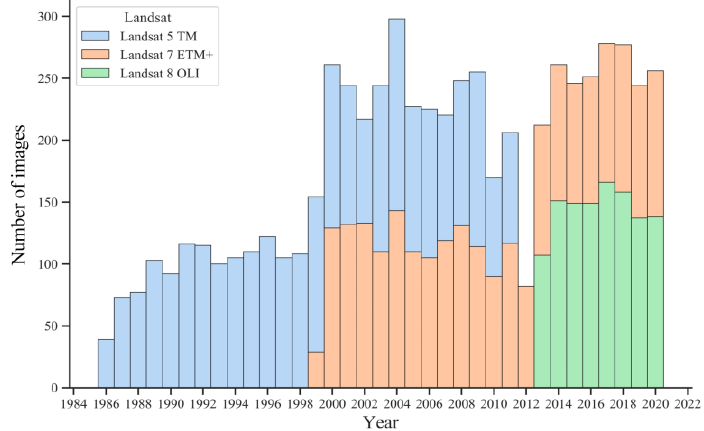
Figure 2. The number of available Landsat images in the GBA for TM, ETM+ and OLI sensors per year.